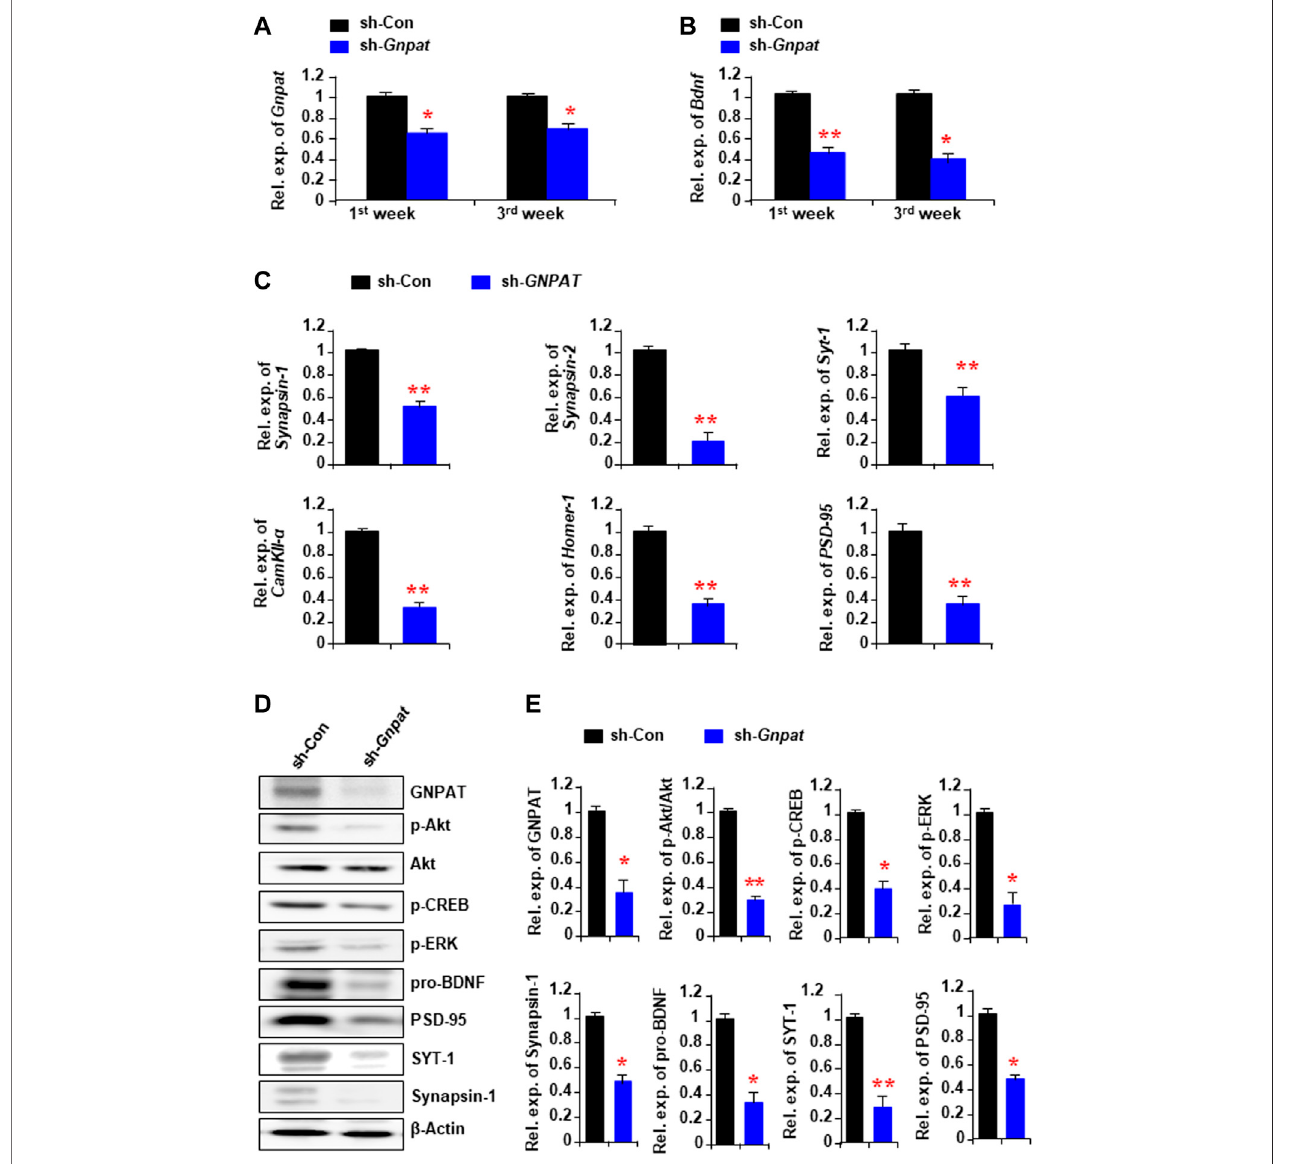
FIGURE 2 | Alteration of memory-related gene expression and cellular signaling in the hippocampus following the Gnpat knockdown. (A,B) Real-time PCR data showthechangesof Gnpat (A) and Bdnf (B) mRNAexpressionsinthehippocampusfollowing1and3weeksaftermicroinjectionofsh- Gnpat lentiviruses. (C) Real-time PCR data show the changes in memory-related gene expressions in the hippocampus 3 weeks after the injections of lentiviruses. (D) Western blotting assays show the representative protein expressions in the hippocampus 3 weeks after the sh-control and sh- Gnpat injection. (E) Quanti fi cation data of panel (D) show the relative change of GNPAT, p-Akt, p-CREB, p-ERK, pro-BDNF, Synapsin-1, SYT-1, and PSD-95 in the hippocampus. The protein expression was normalized with the endogenousexpression of β -Actin. Thedatarepresent themean±S.E.M. Each experiment included more than fi ve mice.*, p < 0.05 and**, p < 0.01. The p valueswere obtained by Student ’ s